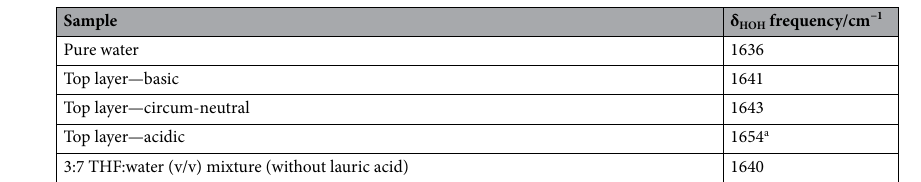
Table 5. Frequency of the water bending mode (δ HOH ) for each sample, prepared either with or without 1 M lauric acid. In the table, the rows labelled as ‘top layer’ refer to the top layer of 3:7 THF:water (v/v) mixtures separated with 1 M lauric acid. a Determined through second derivative